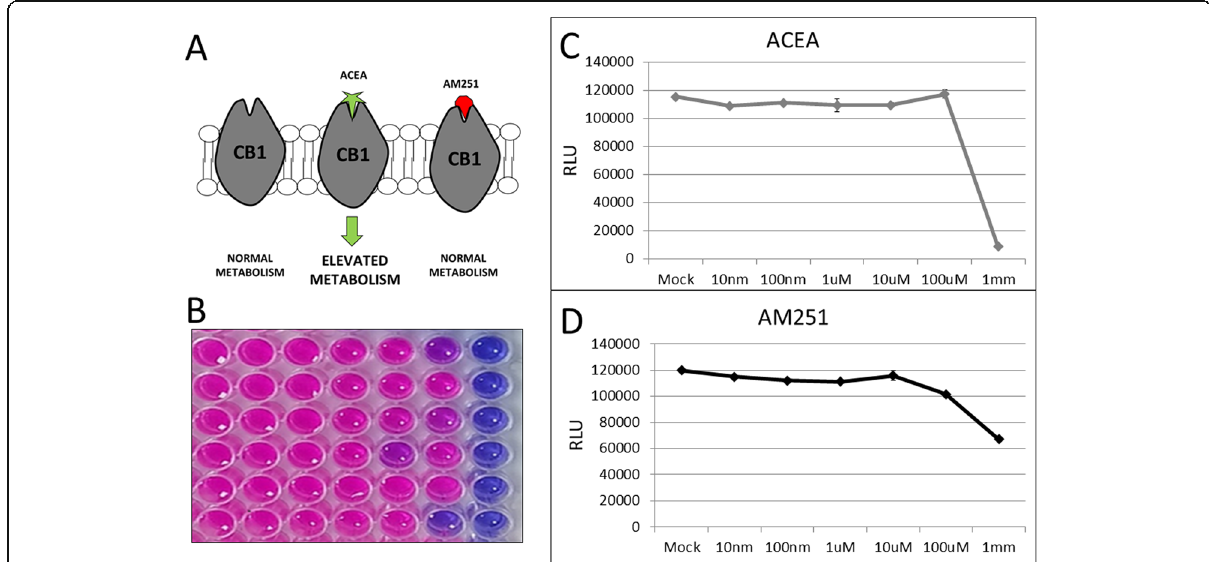
Fig. 2 a CB1 agonist/antagonist diagram illustrating the synthetic cannabinoid compounds used in this study. b Resazurin viability stain to indicate cytotoxicity effects of the cannabinoid treatment. C and d Quantification of cytotoxicity data shown in ( b ). ACEA and AM251 treatment is not toxic to the cells until high concentrations of 1 mM. Treatment with 10 μ M have no adverse cytotoxicity